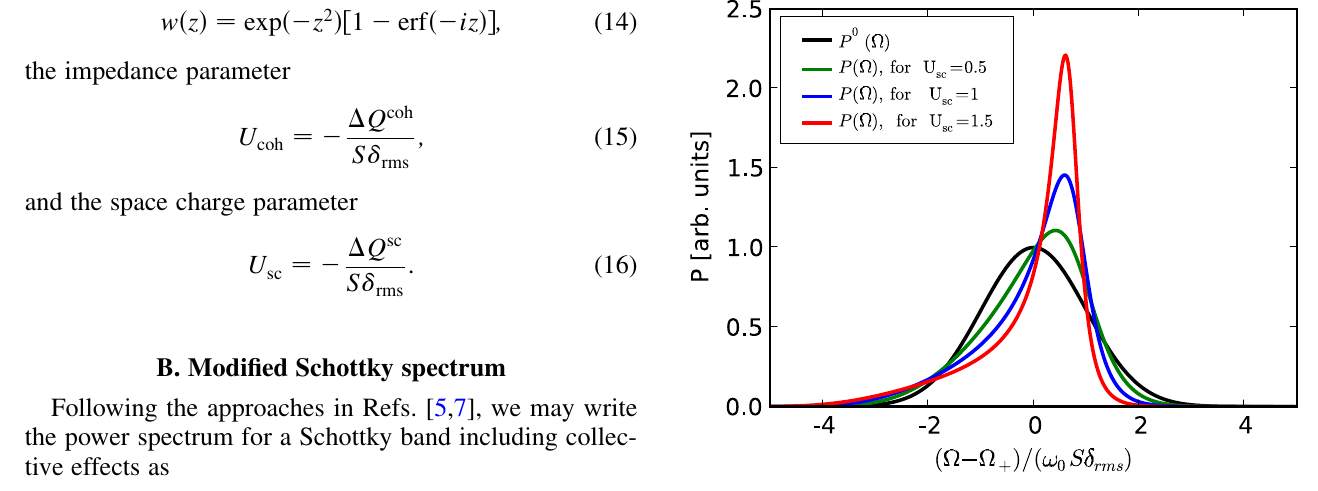
FIG. 2. (Color) P (cid:2) (cid:1) (cid:3) from Eq. (17) for an upper sideband and (cid:4) 0 . with U for different U sc coh